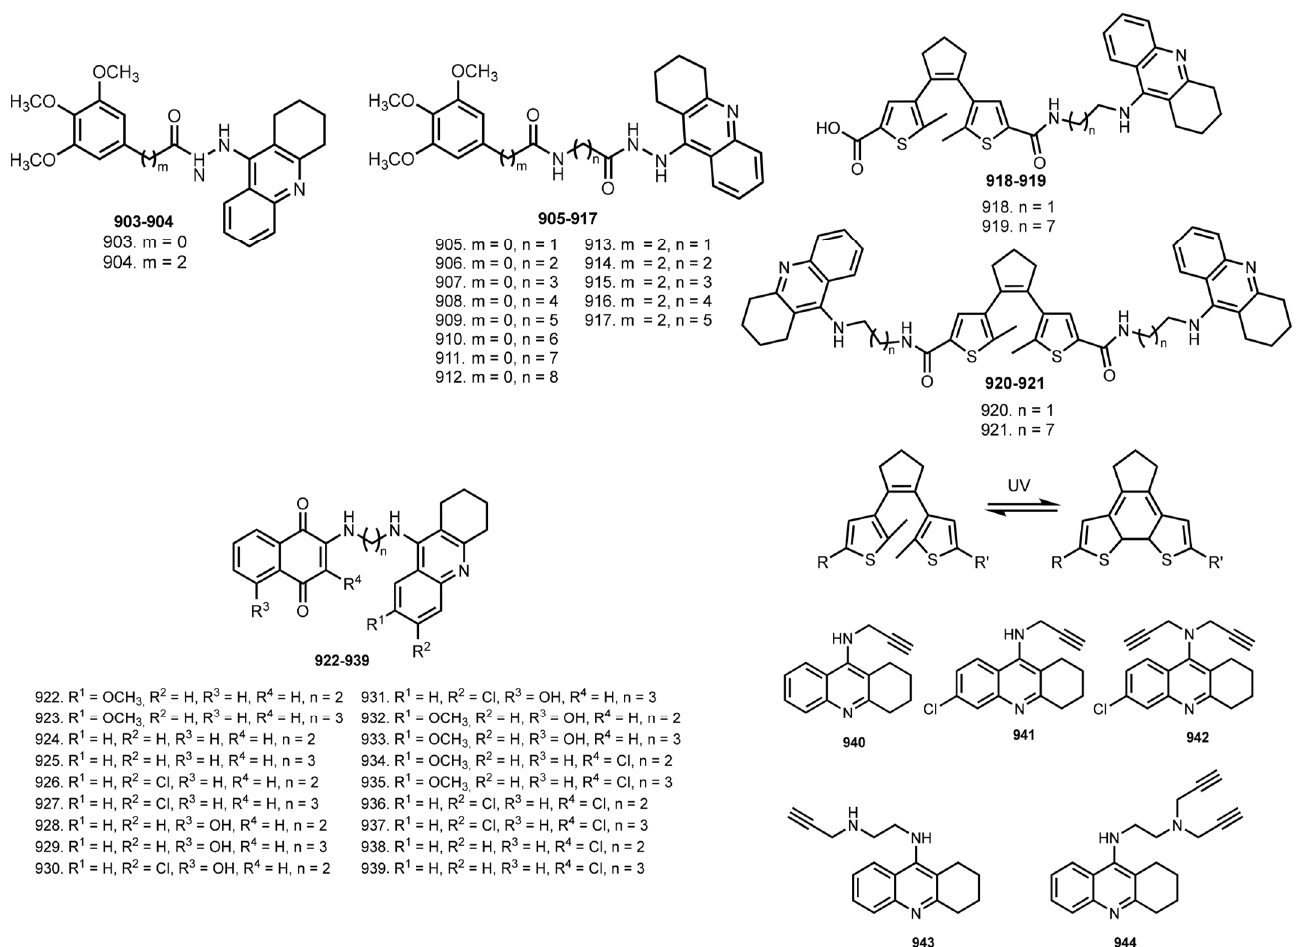
Figure 35. THA ‐ trimethoxybenzene hybrids 903 – 917 [124], photoswitchable hybrids 918 – 921